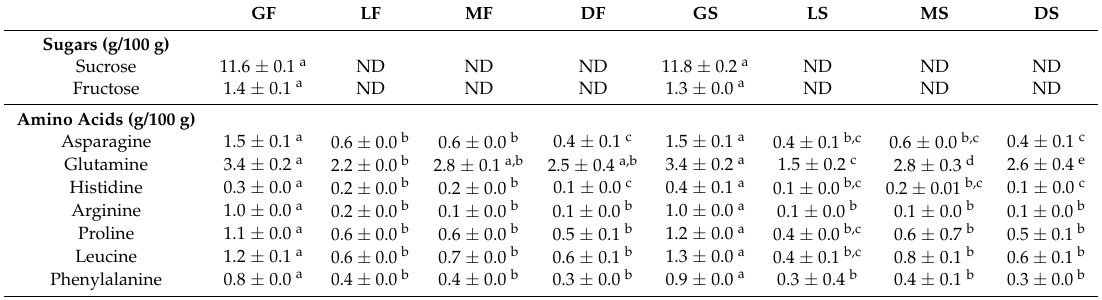
Table 2. Results of sugars and some amino acids for freeze-dried and spray-dried coffee extracts. GF LF MF DF GS LS MS DS Sugars (g/100 g) Sucrose 11.6 ± 0.1